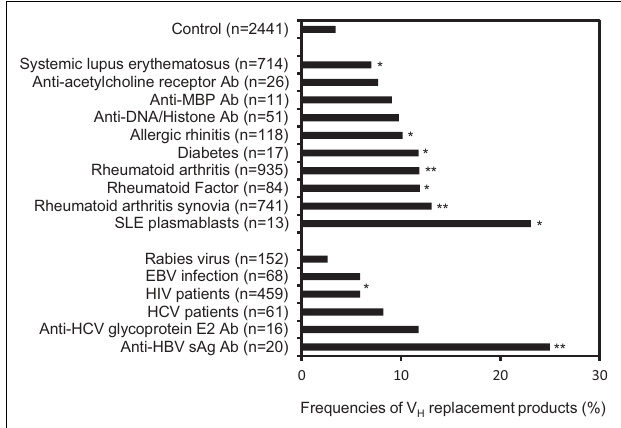
FIGURE 3 |V H replacement products are significantly enriched in IgH genes derived from autoimmune diseases or viral infections and in IgH genes encoding autoreactive or anti-viralAbs . Frequencies ofV H replacement products in IgH gene sequences derived from different sub-categories were analyzed based on the identification of pentamericV H replacement footprints within theirV–D junctions.The frequencies ofV H replacement products in IgH genes derived from different autoimmune diseases and viral infections, or in IgH genes encoding auto Abs, anti-viral Abs, or anti-bacterial Abs were compared with that from healthy controls. The number of analyzed IgH gene sequences in each subcategory are indicated ( n ).The arrow head indicates the overall frequency ofV H replacement products (12.1%) in the 39,438 unique human IgH sequences. Statistical significance was determined using a two-tailed Chi square test withYate’s correction. * p < 0.05 is considered statistically significant and ** p < 0.0001 is considered extremely statistically